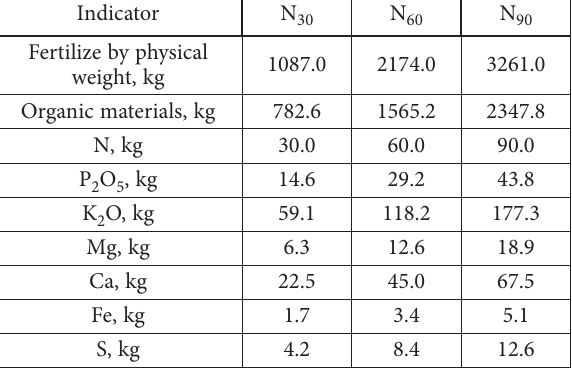
Table 4. The influence of granulated cattle manure compost fertilizer (IP1) rates on soil biodegradation processes Fertilizing P 2 O 5 , pH rates mg . kg −1